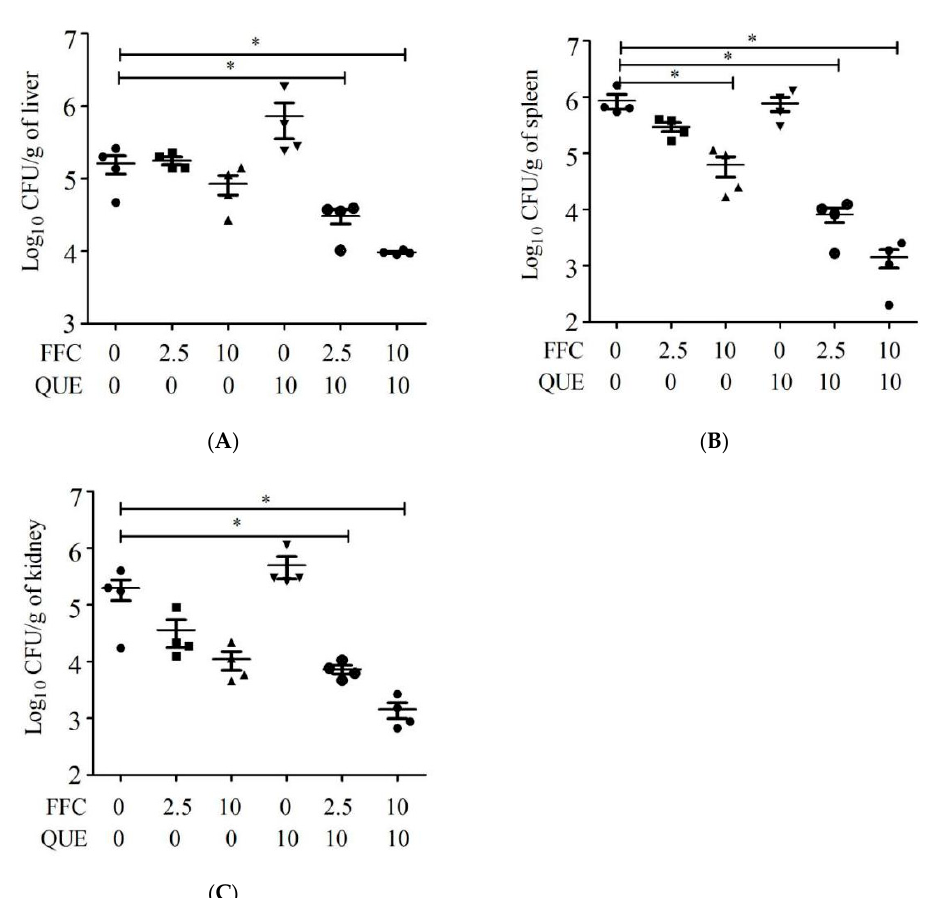
Figure 4. The bacterial load of A. hydrophila in liver ( A ), spleen ( B ) and kidney ( C ) of C. carpio ( n = 6) after treatment with quercetin, florfenicol and their combination. QUE, quercetin; FFC, florfenicol. Each point represents data from an individual tissue. * p < 0.05.